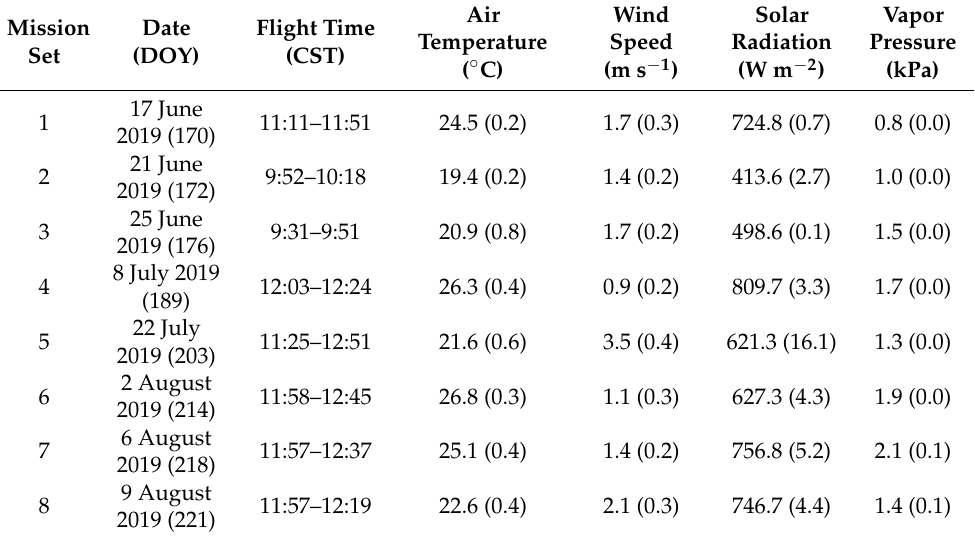
Table 1. Remotely Piloted Mission Sets. Meteorological data were averaged values from 30-min before and after the midpoint of each flight mission. Standard deviations over this time period are listed within